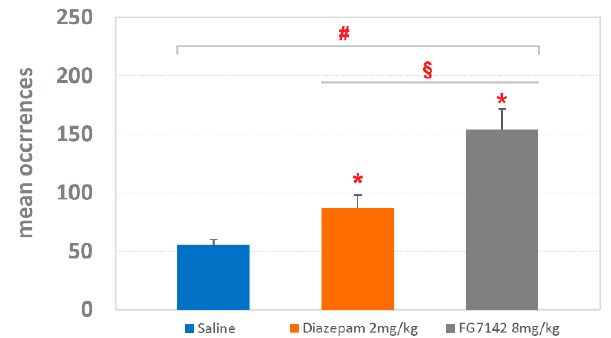
Figure 7. Mean occurrences ± SEM of T-patterns detected in rats injected with saline, diazepam 2 mg/kg and FG7142 8 mg/kg. # = statistically significant ( p < 0.05) ANOVA result; * = significant ( p < 0.05) difference of diazepam or FG7142 groups in comparison with saline group (Newman–Keuls post-hoc test for multiple comparisons); § = significant ( p < 0.05) difference between diazepam and FG7142 groups (Newman–Keuls post-hoc test for multiple comparisons). Data obtained from the analysis of three groups each encompassing 10 subjects. See Figure 1 for abbreviations.